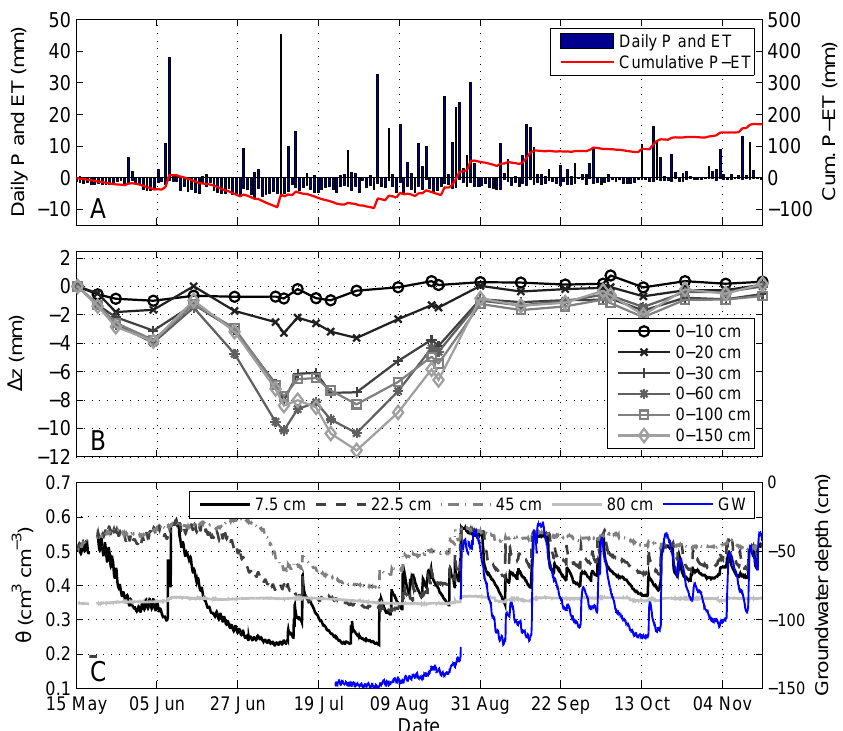
Fig. 9. Daily precipitation P , daily evapotranspiration ET and cumulative net precipitation P -ET (A) , cumulative layer thickness change 1z in six soil layers (B) , volumetric soil moisture content θ from CS616 sensors at four depths and groundwater depth (C) at field B from 15 May until 15 November 2010. Note that soil moisture data logging failed between 18 May and 20 May, and groundwater level measurements started at 22